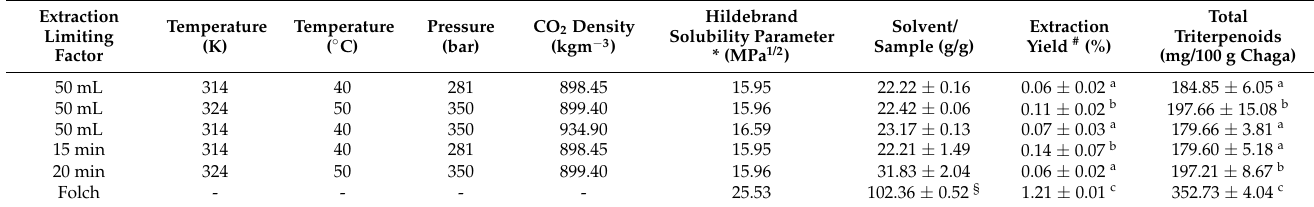
Table 1. Extraction yield and total extracted terpenes using SFE and Folch methods and corresponding extraction conditions. Data are expressed as means ± standard deviation. The different letters (a–c) indicate significant difference ( p < 0.05).